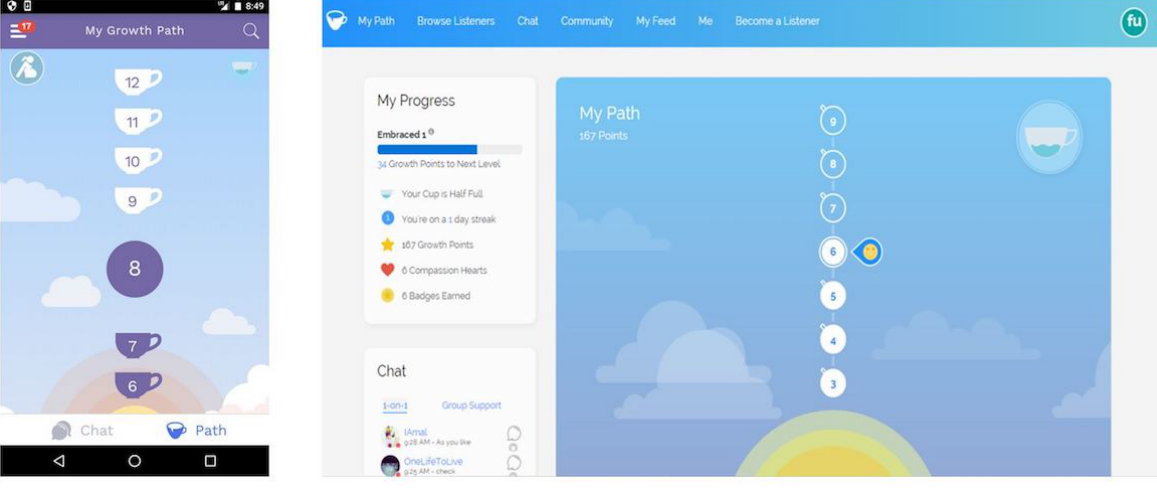
Figure 3. 7Cups Growth Path feature: mobile (left) and computer